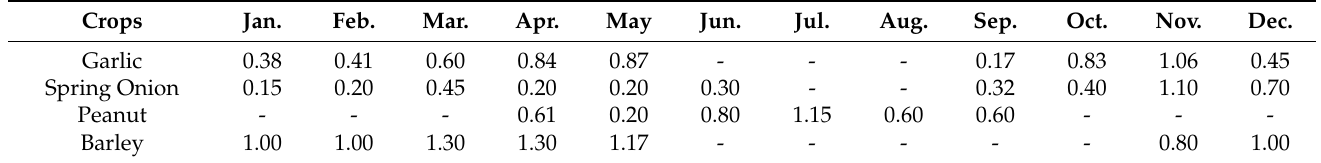
Table 2. Crop coefficients ( k c ) used for garlic, spring onion, peanut, and barley (KARICO, 2005) [28]. Crops